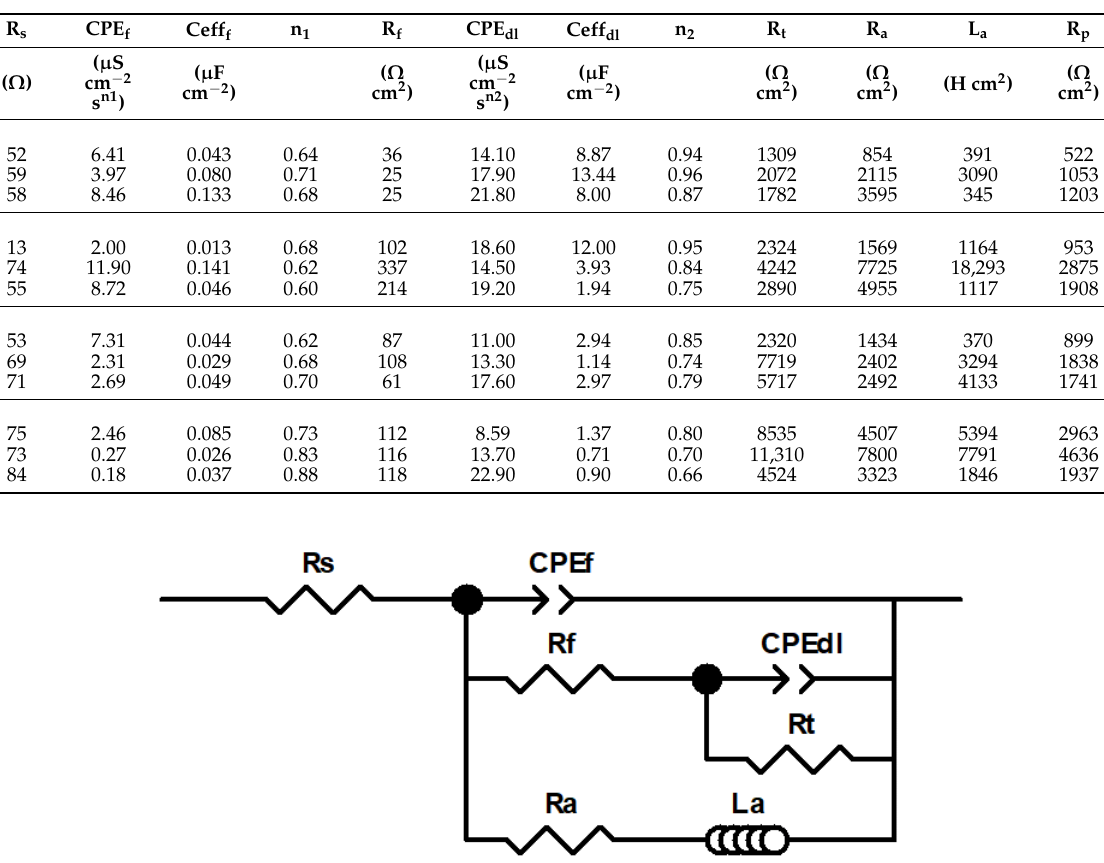
Figure 7. Electrical equivalent circuit (EEC) used for fitting the experimental electrochemical impedance spectroscopy (EIS)